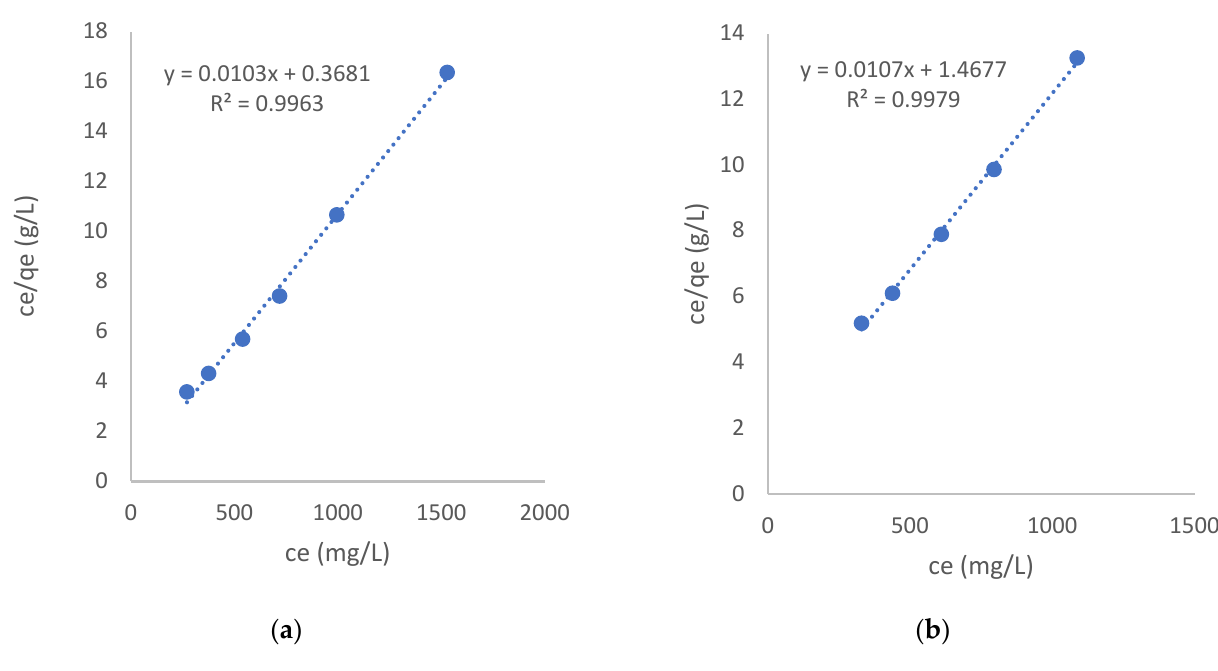
Figure 8. Langmuir model fit for RF_ac ( a ) and RMF-GO ( b ).